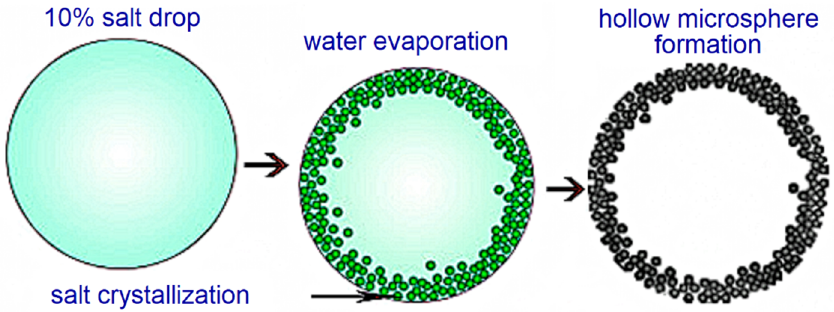
Figure 2. Formation scheme of hollow copper (II) oxide microspheres.